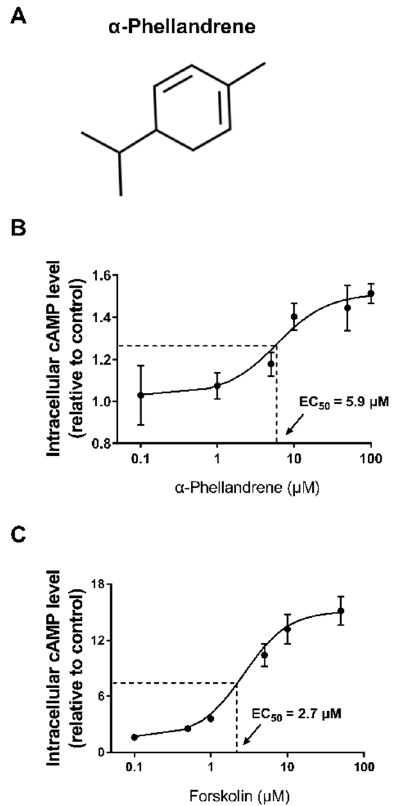
Figure 1. α -phellandrene increases cyclic adenosine monophosphate (cAMP) levels in dermal papilla cells (DPCs). ( A ) The structure of α -phellandrene. ( B , C ) Total cAMP content was measured in DPCs after 30 min stimulation with vehicle (dimethyl sulfoxide; DMSO) or various concentrations of α -phellandrene or forskolin. Results are expressed as mean ± standard error of the mean (SEM) of three independent experiments.